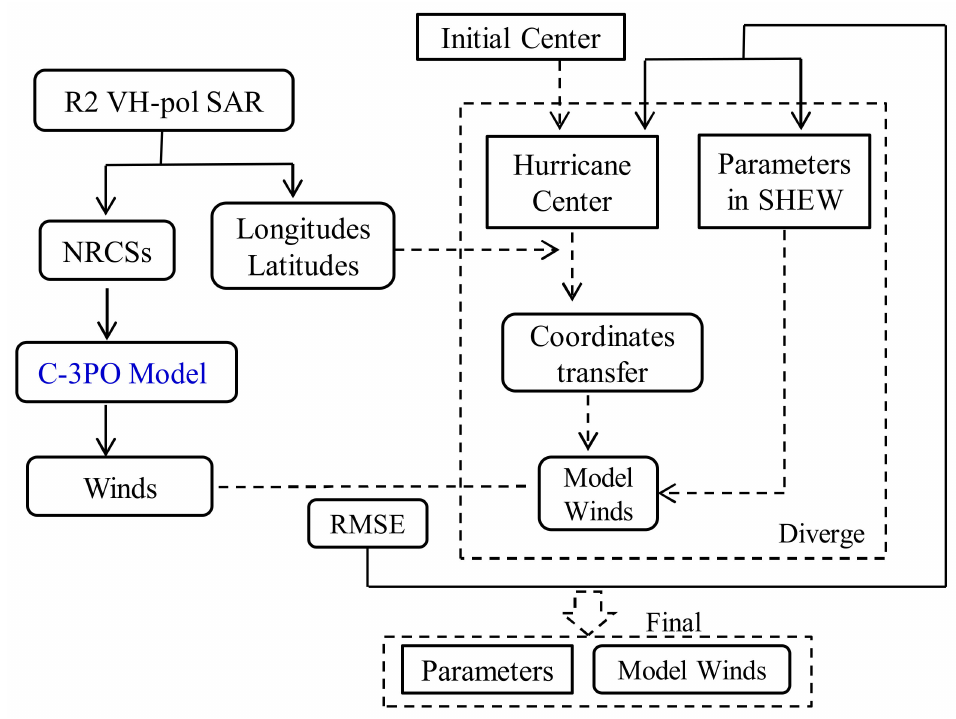
Figure 4. Flowchart for the modified SHEW model to estimate the hurricane double-eye